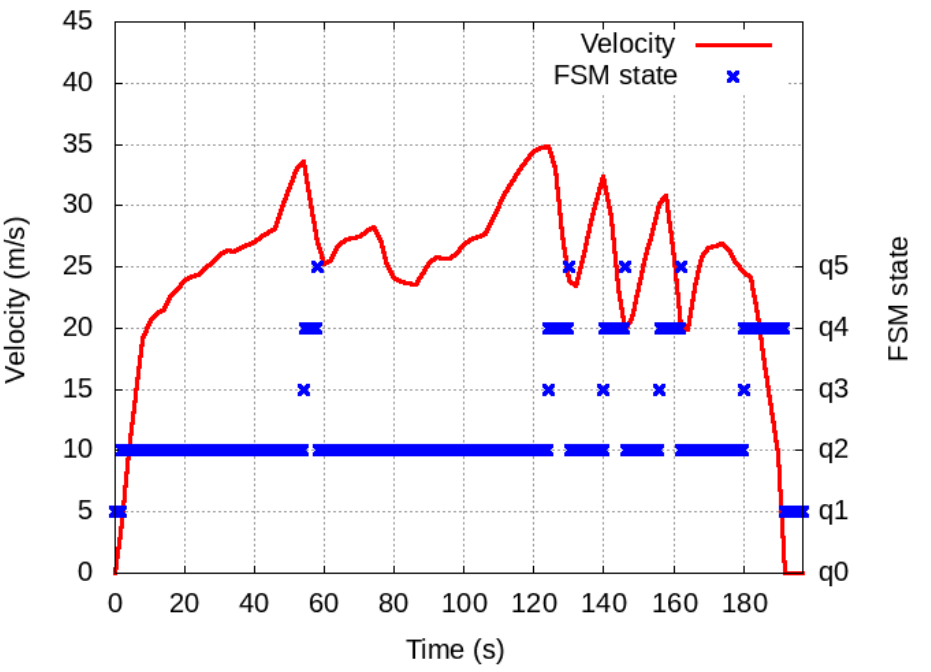
Figure 9. Velocity and FSM states diagram, created from data logged during the 2nd lap of the Shell Eco-marathon Europe 2019.